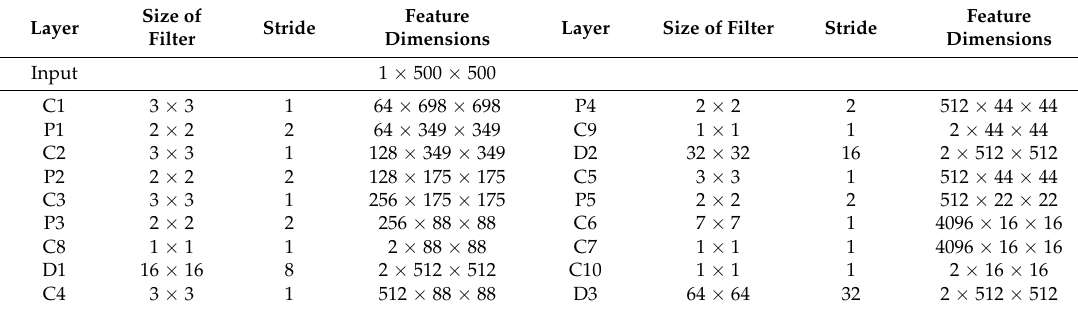
Table 1. The architecture of FCN for sea-land